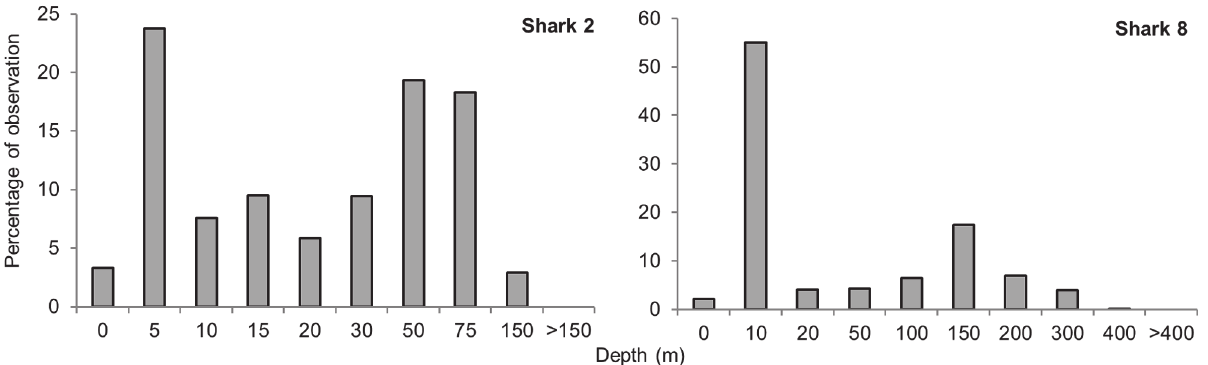
Fig 5. Time spent in each depth bin. Percentage of time spent in each depth bin for two tiger sharks tagged with SPLASH